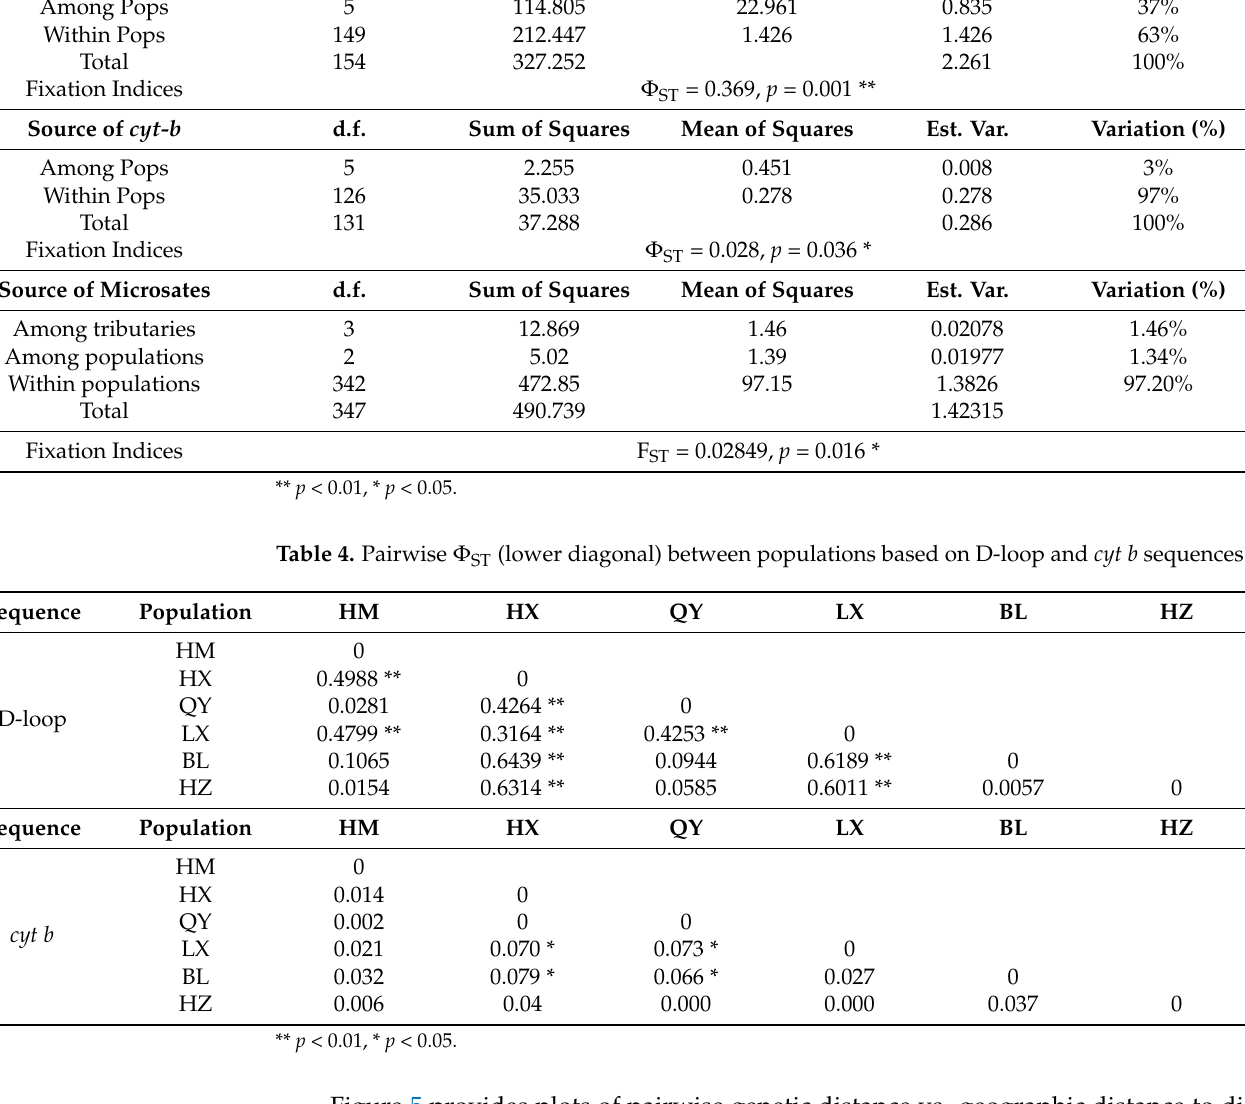
Figure 5 provides plots of pairwise genetic distance vs. geographic distance to dis- tinguish the correlations between genetic distance and geographic distance among the populations based on the D-loop sequences and microsatellite data. The Mantel test showed that the divergence of the C. grayii geographic populations in the Pearl River was consistent with the geographical isolation model (IBD model). The genetic differentiation among populations was positively correlated with the geographical distance of the pairwise popu- lations ( R 2 = 0.5983, p = 0.0028 **) (Figure 5a) or all six populations, excluding